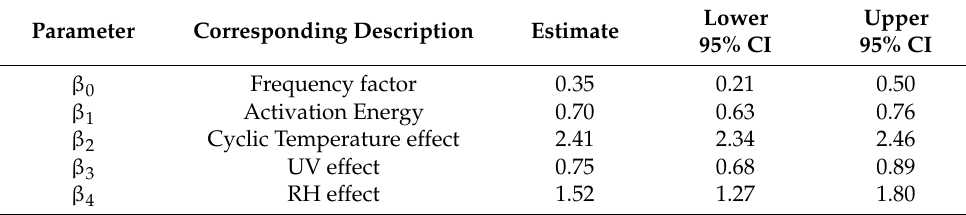
Table 1. Parameter estimates of cumulative effects model along with confidence interval [22].